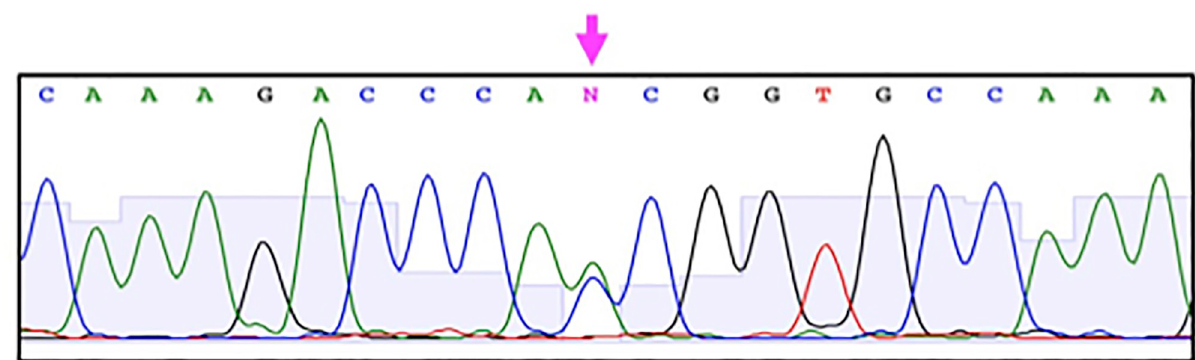
Fig 2. Electropherogram of heterozygous 905A > C in PHOX2B .